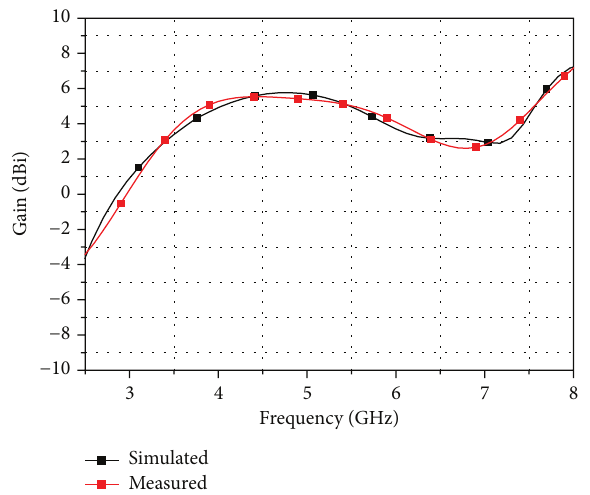
Figure 10: Measured and simulated gain for the proposed CPW-fed two-sided T strip wideband microstrip antenna.